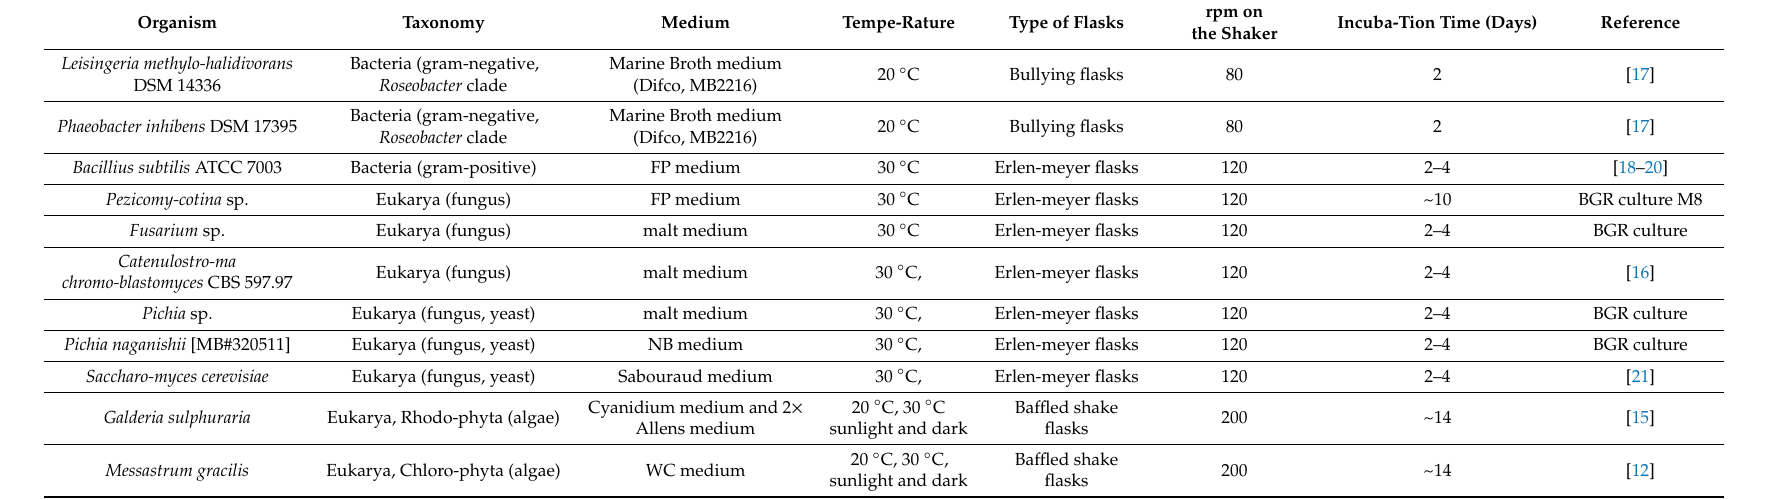
Table 1. Cultivation conditions for microorganisms used for biosorption